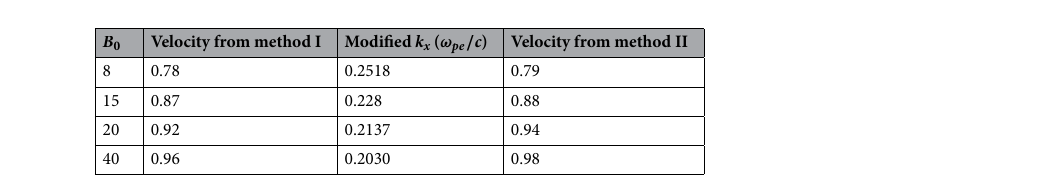
Table 4. Velocity of EM wave (normalized to c) in plasma with changing magnetic